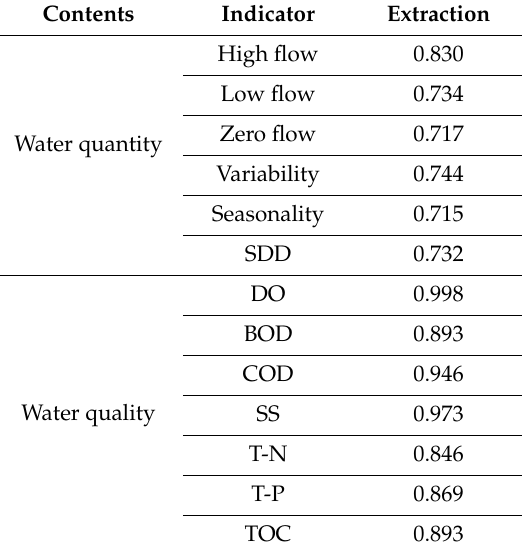
Table 11. The results of the communality values by all indicators of water quantity and water